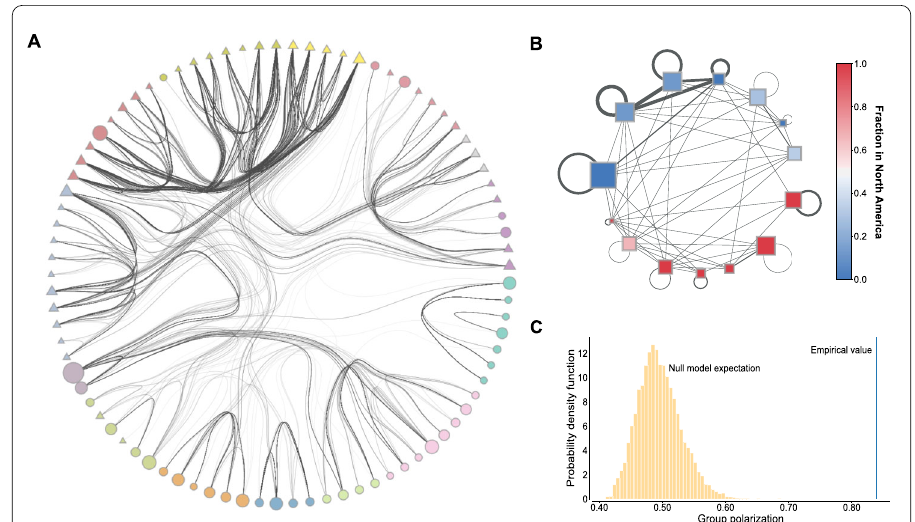
Figure 2 Stochastic block model and group polarization for the collaboration network in the field of inequalities in health. (See Supplementary Figs. S3-S9 for all other fields). ( A ) Collaboration network and best fit of the hierarchical stochastic block model (hSBM). Each node in the network represents a prominent researcher, and each edge represents a different collaboration (coauthored paper) between a pair of researchers. Prominent researchers in North America and Europe are represented as circles and triangles, respectively. Different colors correspond to the groups identified by the hSBM, so that nodes with the same color have a similar collaboration pattern with other researchers and therefore fulfill a similar structural role in the collaboration network. Node size represents the betweenness centrality of the researcher in the network. We omit the names of the researchers so as not to distract from the patterns we aim to explore; for reproducibility, we provide the names of the prominent researchers in Supplementary Fig. S2, and in Supplementary Figs. S3-S9 for the other fields. ( B ) Block model of the collaboration network. Each node represents a group of researchers with similar collaboration patterns (that is, a different color in ( A )), with node size representing the number of researchers in the group. The width of the edges represents the number of collaborations between groups, and loops represent collaborations within each group. The color of each node indicates the fraction of researchers in the group that are based in North America, so that dark blue nodes represent groups with mostly Europe-based researchers, and red nodes represent groups with mostly North America-based researchers. ( C ) We define the polarization of a group as the number of same-continent researchers in the group over the random expectation for such number (Methods). The vertical line indicates the mean group polarization for the observed collaboration network. We randomize authors’ affiliations and calculate the distribution of expected (null) polarization values. The empirical value is well above the